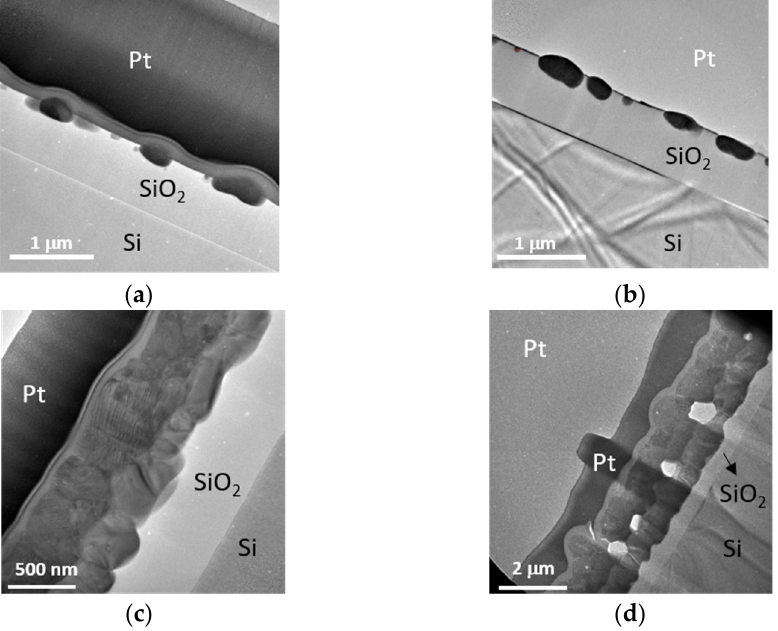
Figure 5. Cross-section TEM images for the following samples: ( a ) LT-LP; ( b ) LT-HP; ( c ) HT-HP; ( d ) HT-LP. The scale bars are provided in the figures.